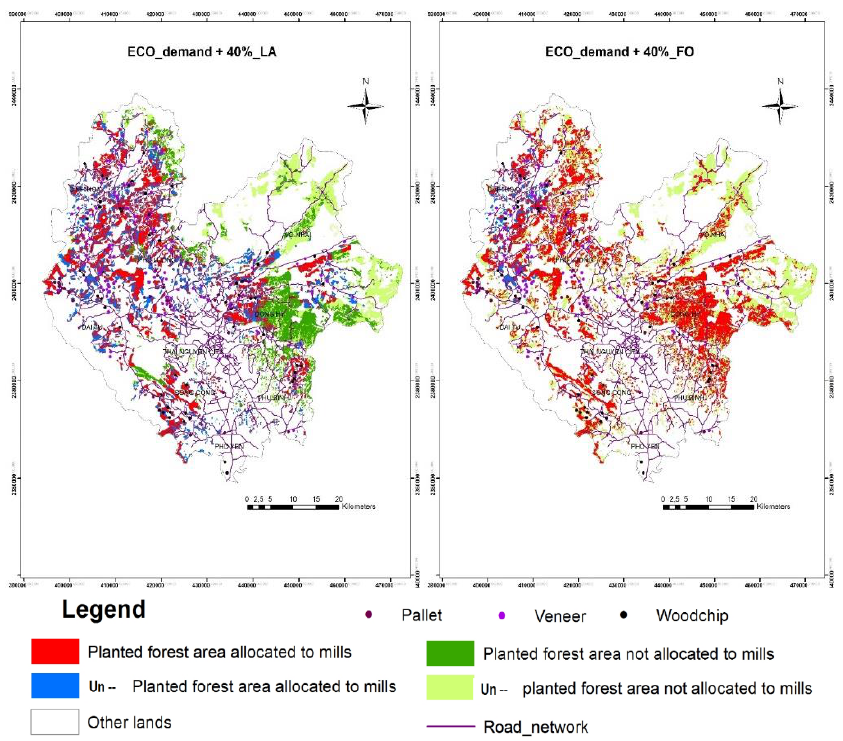
Figure 10. Spatial distribution of land area allocated by increasing timber demand 40% under the landscape approach (_LA) and the current forest approach (_FO).